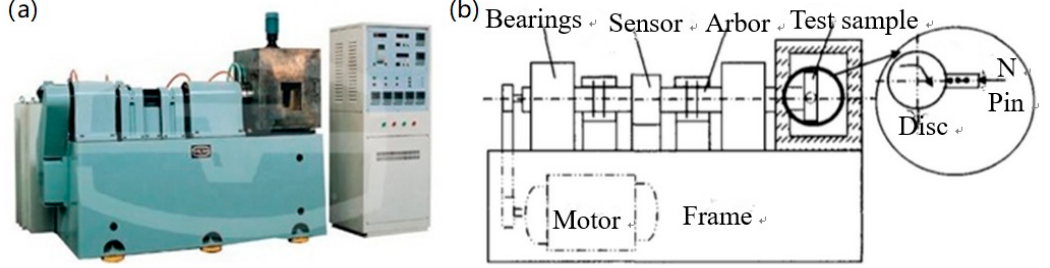
Table 1. Chemical compositions of pin and disk specimens.